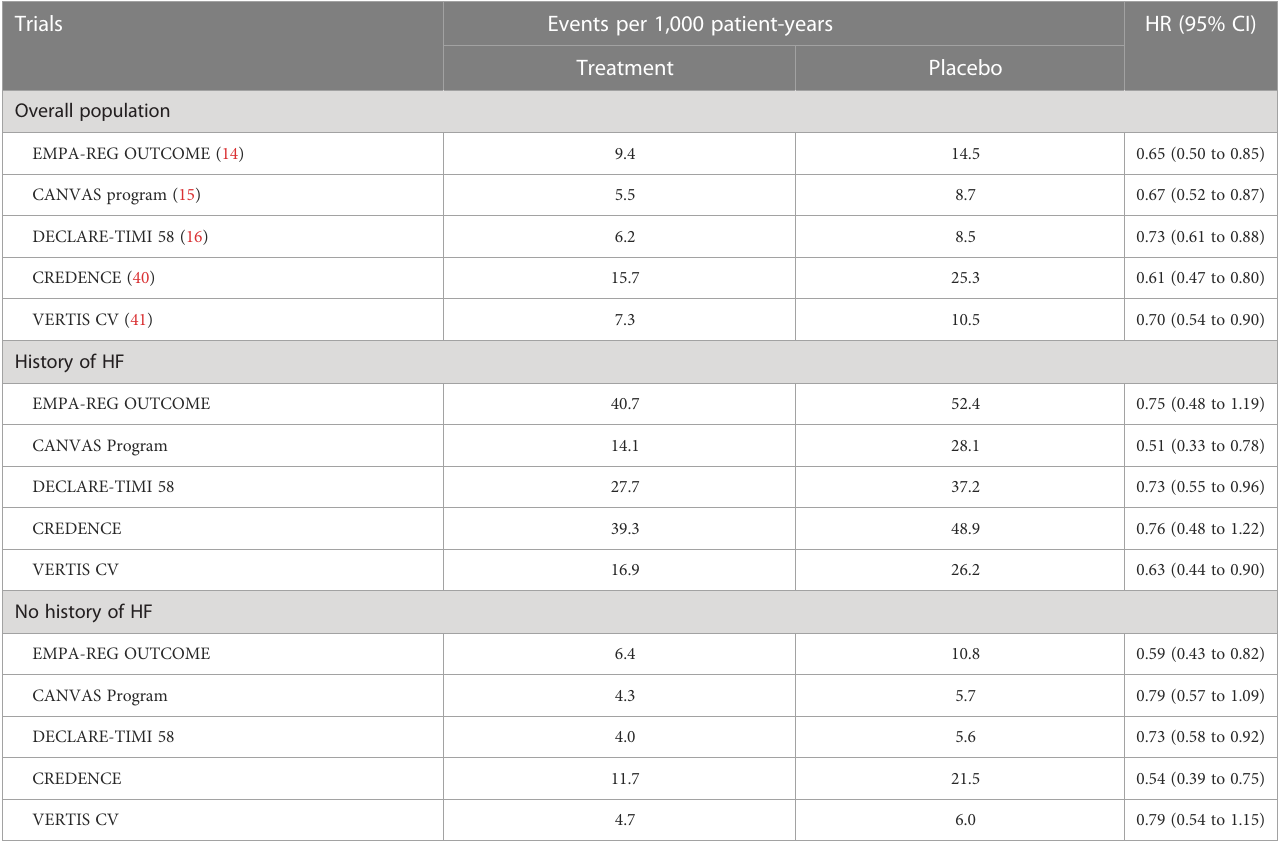
TABLE 1 Hospitalization for heart failure among patients with type 2 diabetes mellitus with and without a history of heart failure.